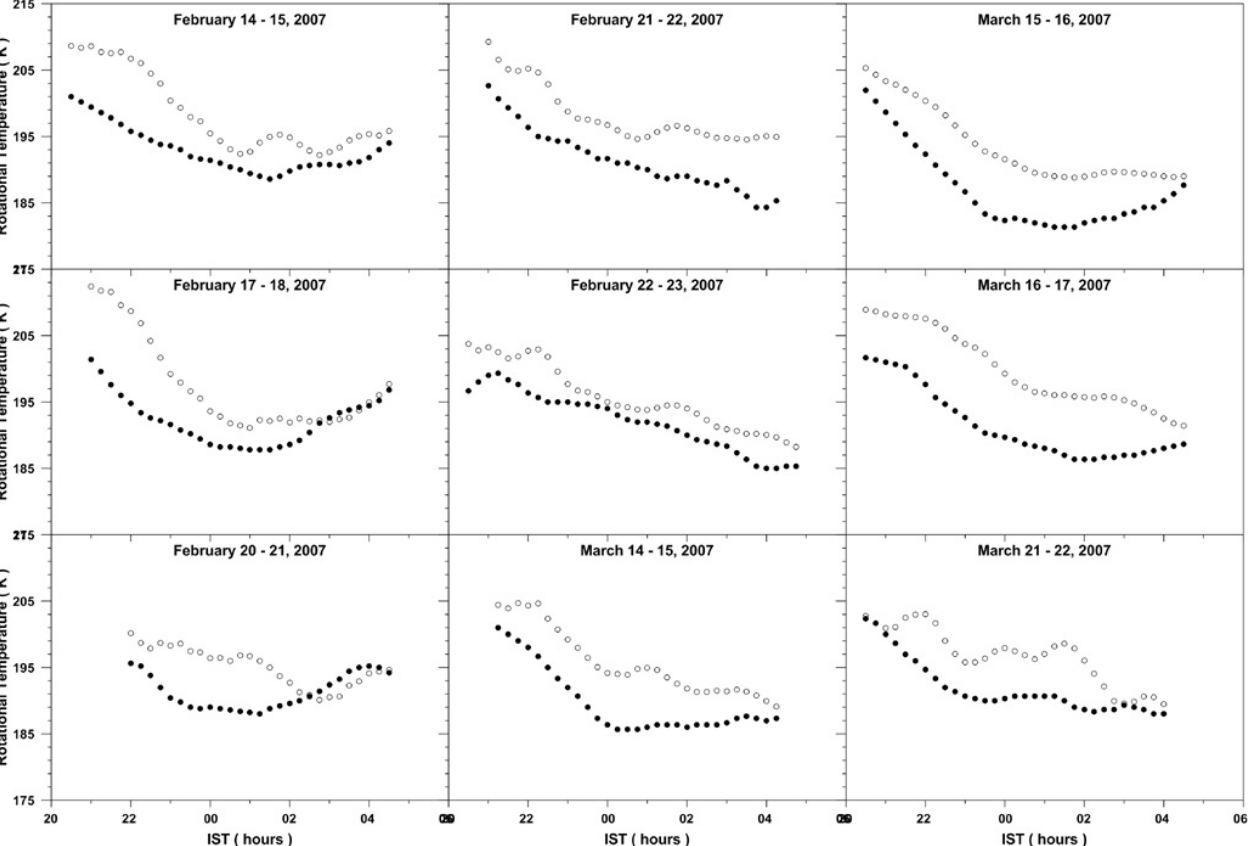
Fig. 4. Nocturnal variation of OH (open circles) and O 2 (solid circles) temperatures during some